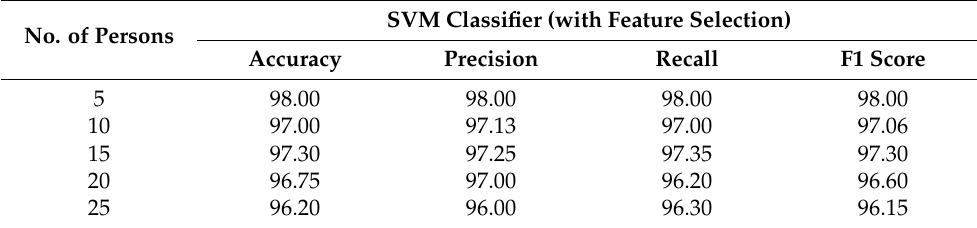
Table 7. Confusion Matrix of Classification using Optimal Feature Sets.